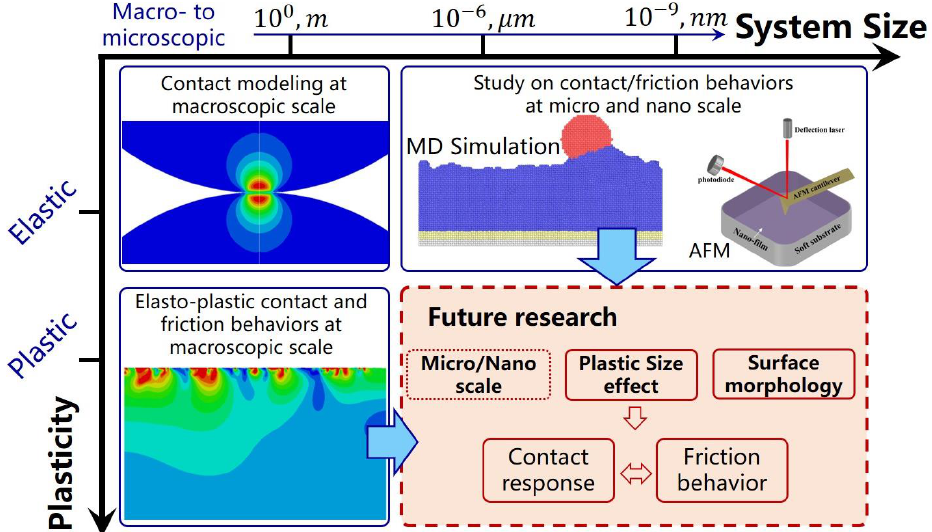
Figure 12. A plasticity vs. length-scales map of models developed in tribology: elastic contact modeling at macroscopic scale, elasto-plastic contact and friction behaviors at macroscopic scale, simulation [156] and experimental methods at micro and nano scale, and future research focus.